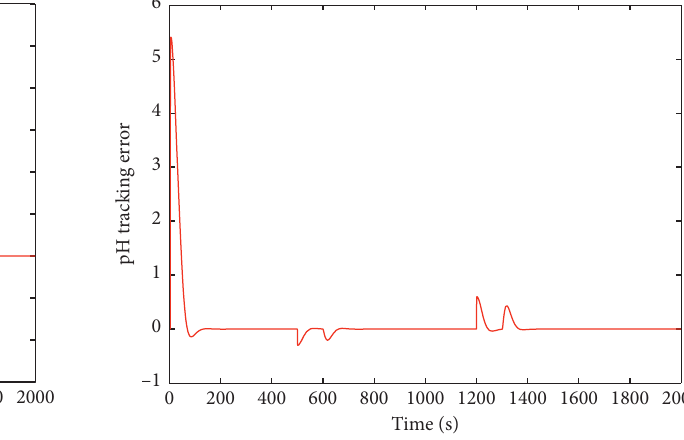
Figure 7: pH tracking error curve.